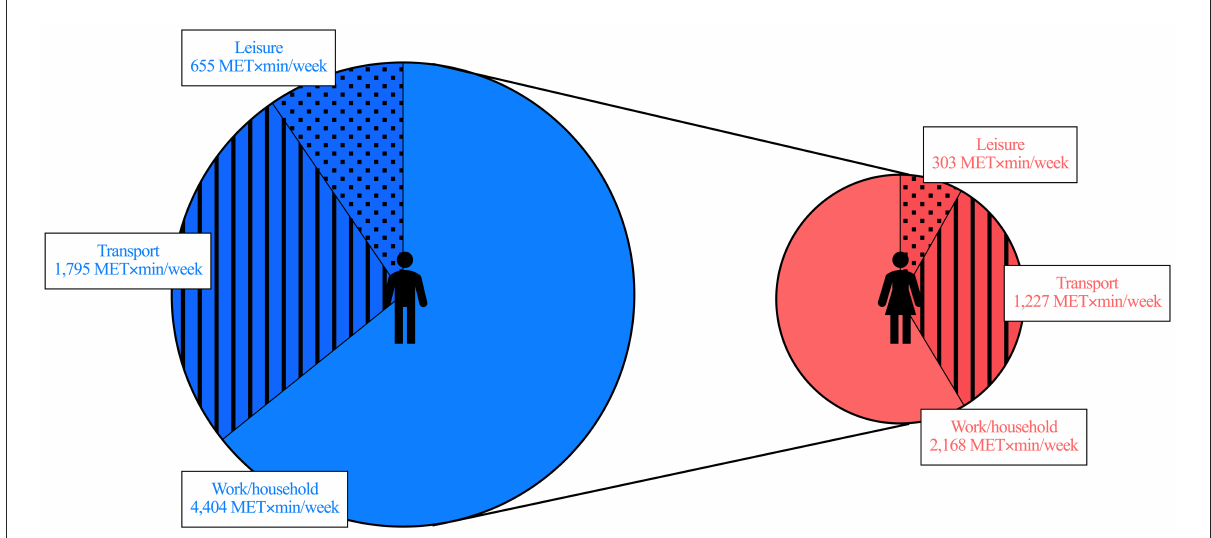
FIGURE4 Sex gap in moderate-vigorous physical activity (MVPA) in Chile. Data represent the mean values of MVPA by domain for men (left) and women (right) . This is a schematic representation of the data from Figures